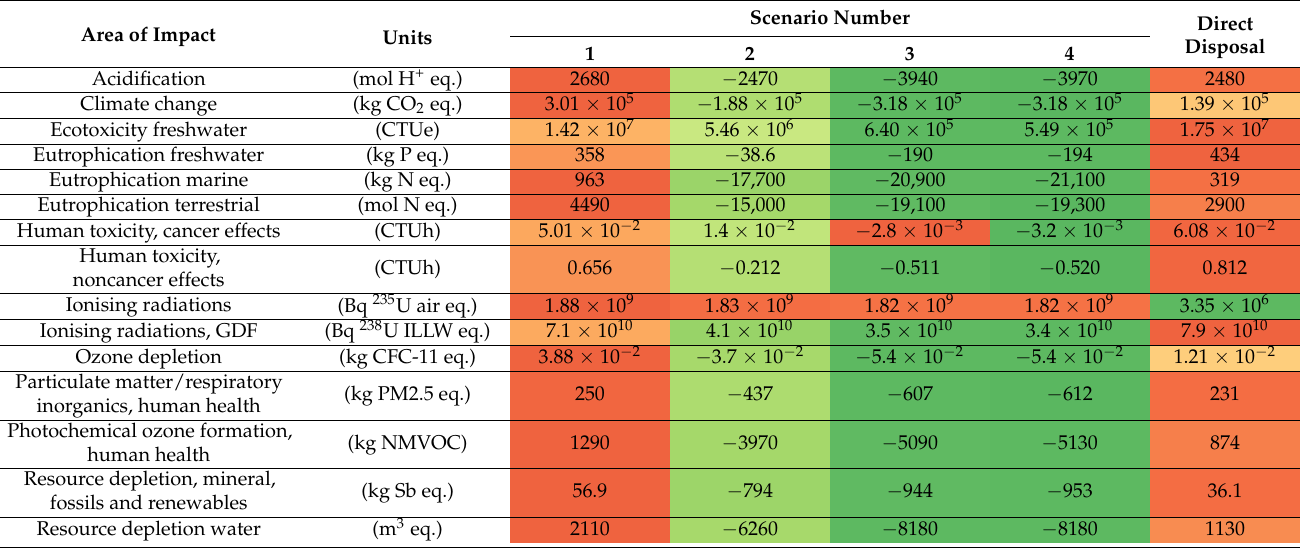
Table 7. Environmental impacts of reprocessing scenarios and direct disposal